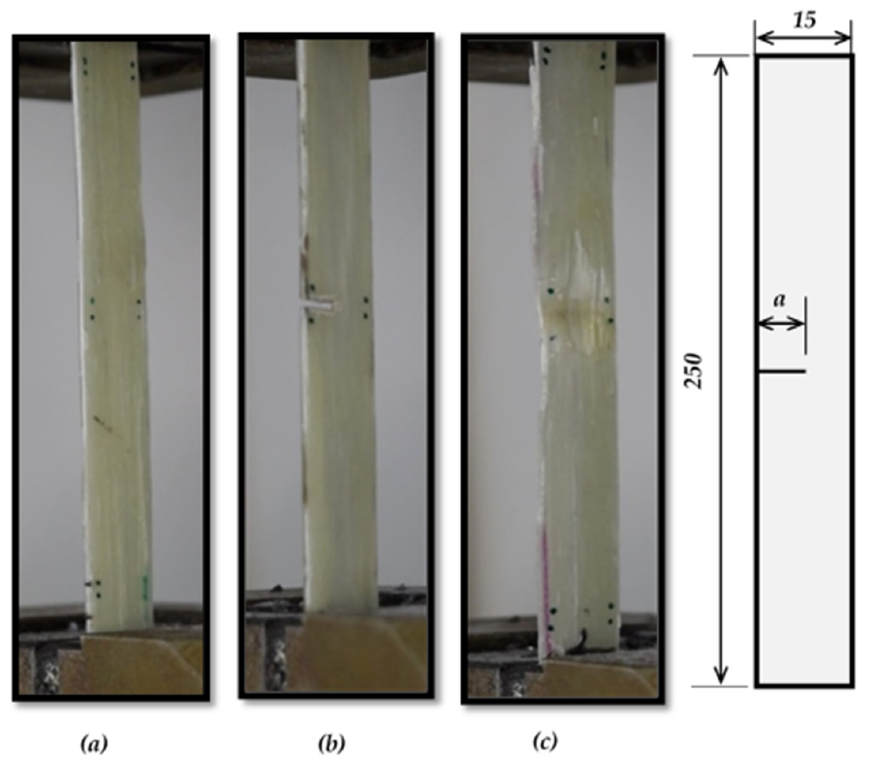
Figure 4. The geometry of ASTM D3039 specimens, ( a ) smooth specimen, ( b ) TTC specimen, and ( c ) MC specimen. All dimensions in mm.